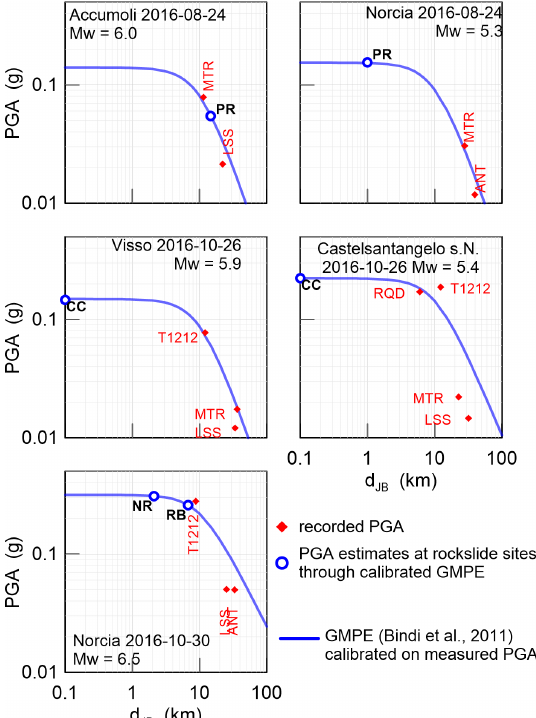
Figure 4. PGA estimate through a calibrated GMPE for each shock. For the PR rockslide and the CC rockslide, two shocks are consid- ered on 24 August and on 26 October, respectively.